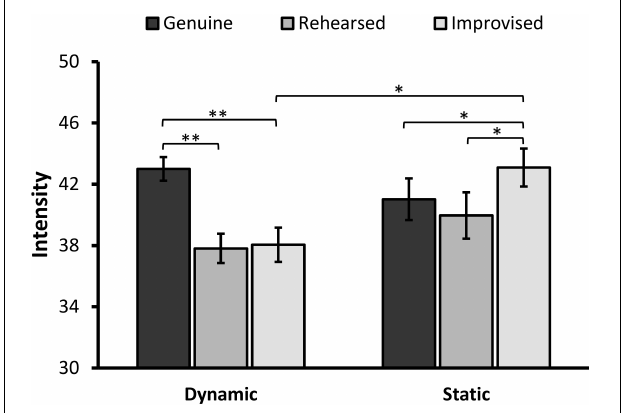
FIGURE 4 | Mean ratings for perceived intensity of facial expressions (error bars ± 1 SE). The asterisks represent a significant difference at ∗ p < 0.01 and ∗∗ p <